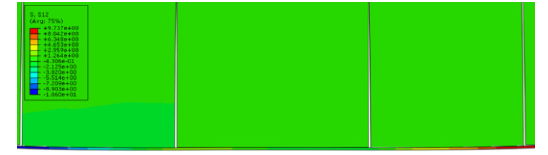
Fig. 13. Shear stresses at the interface of CFRP and concrete in the vicinity of the cracks After running 27 models for each test group and comparing the results of numerical models with those from experiments 1 mm, 80 mm and 85%xh were selec- ted for crack width, interval and length,